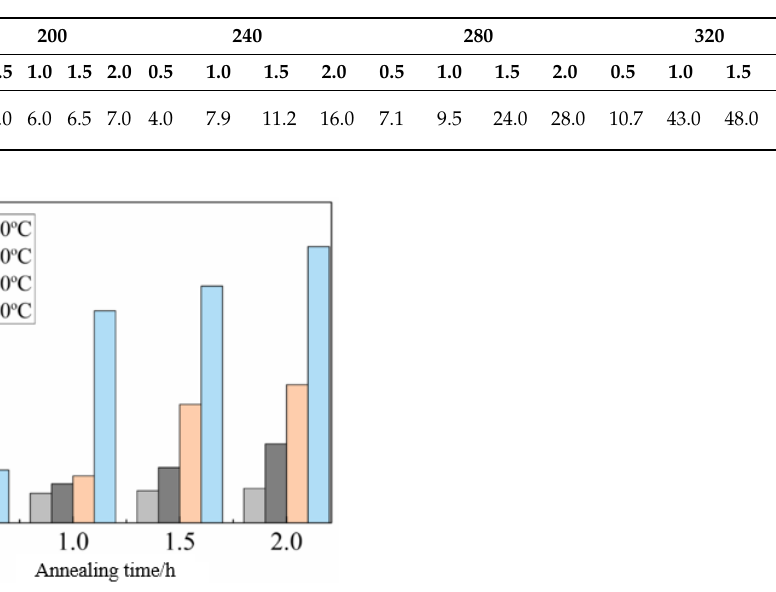
Table 2. Thickness of the interfacial diffusion layer of the Al/Zn laminate composite plate at different temperatures ( T) and times ( t ).